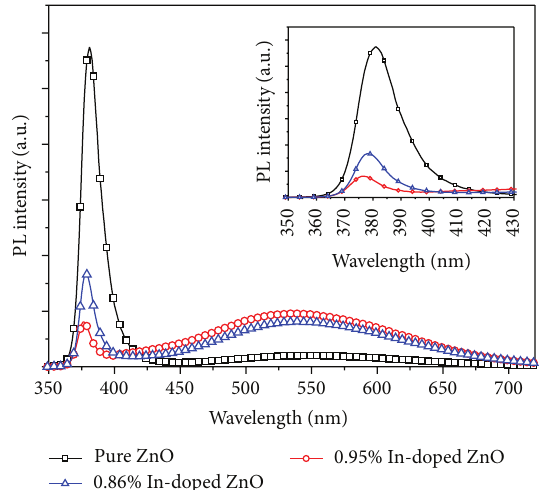
Figure 5: Room temperature PL spectra of ZnO and ZnO:In NWs. The inset shows the UV-region PL